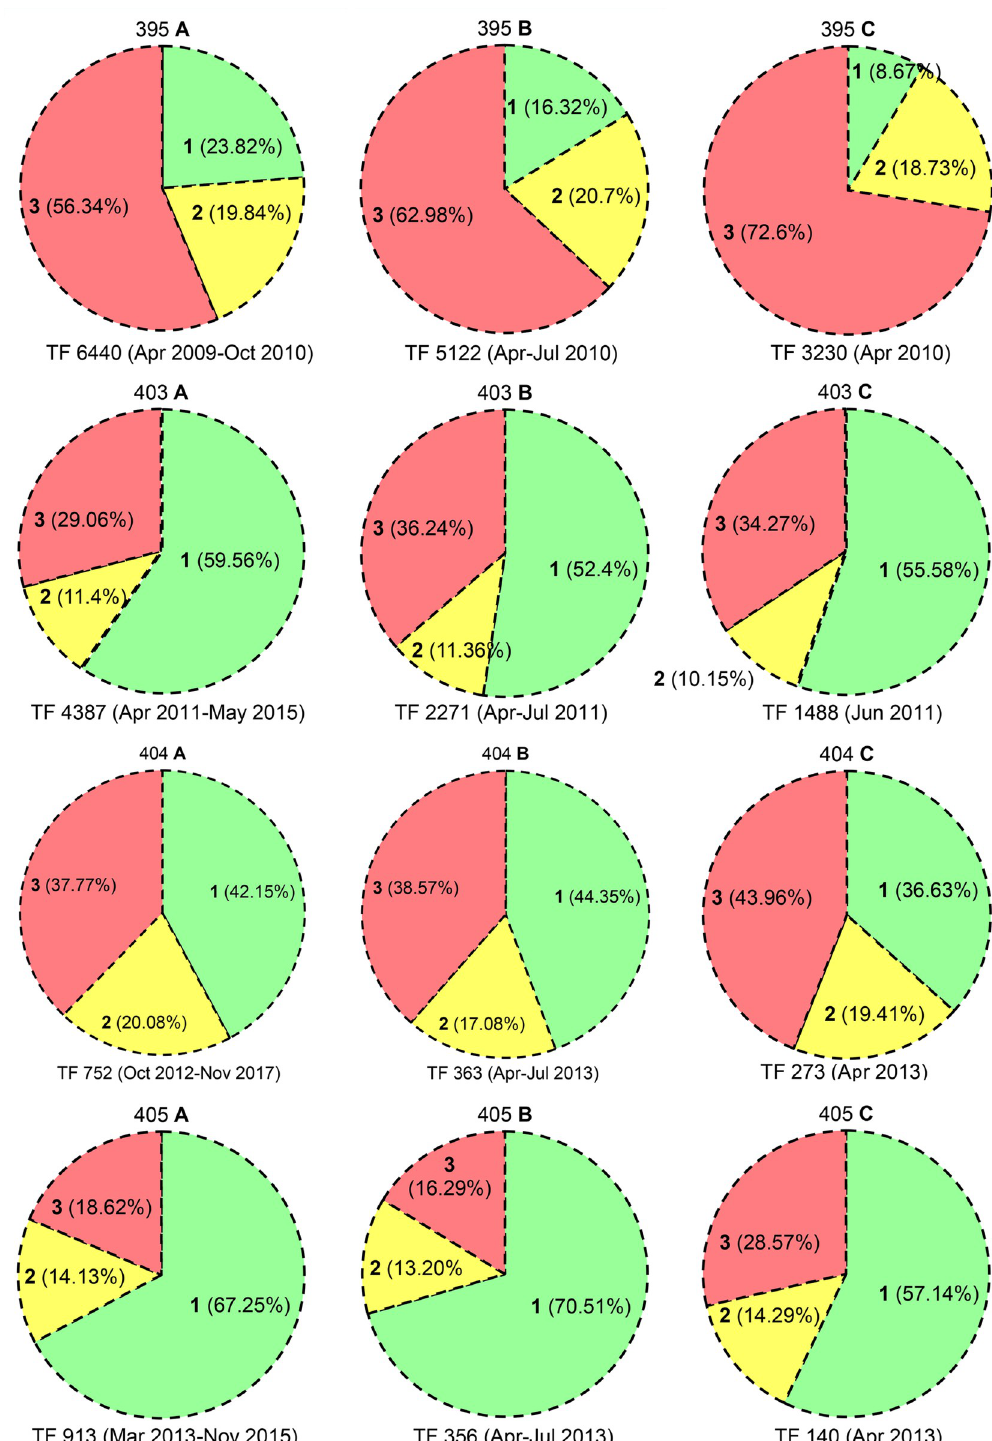
Fig 7. High reward, high predation. M . baccifera clumps: 395, 403, 404, 405; A. TF— Total fruits ; 1 , % GF ( Good fruits ), 2 , % IF ( Immature fruits ), 3 , % PF ( Predated fruits ) in the full flowering period of the clump; B. TF— Total fruits ; 1 , % GF, 2 , % IF, 3 , % PF in April-July of the year in which the clump recorded highest fruit production in a single month; C. TF— Total fruits ; 1 , % GF, 2 , % IF, 3 , % PF in a single month of highest fruit production.